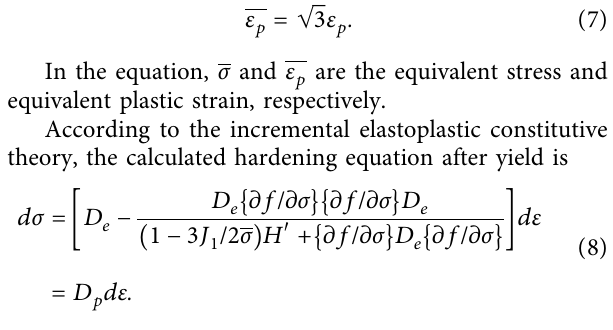
Figure 2: Schematic diagram of constitutive model parameters.